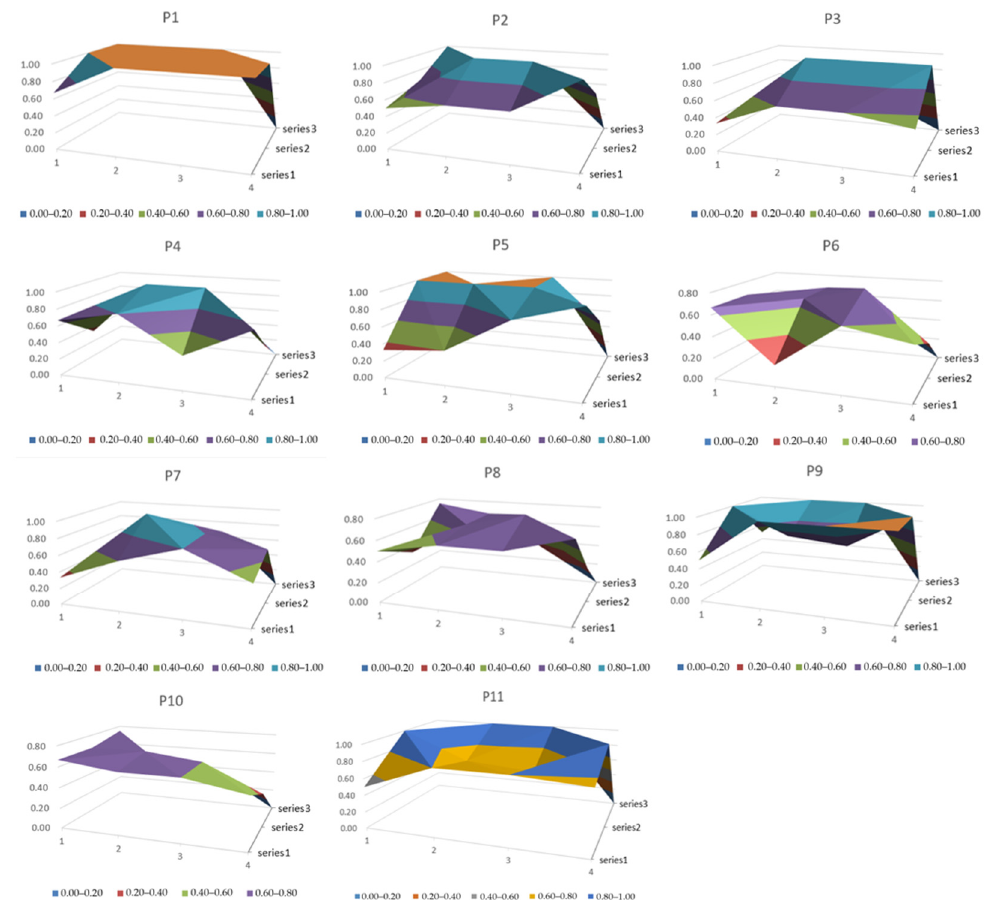
Figure 4. PMC surface of 11 PCECN policies.